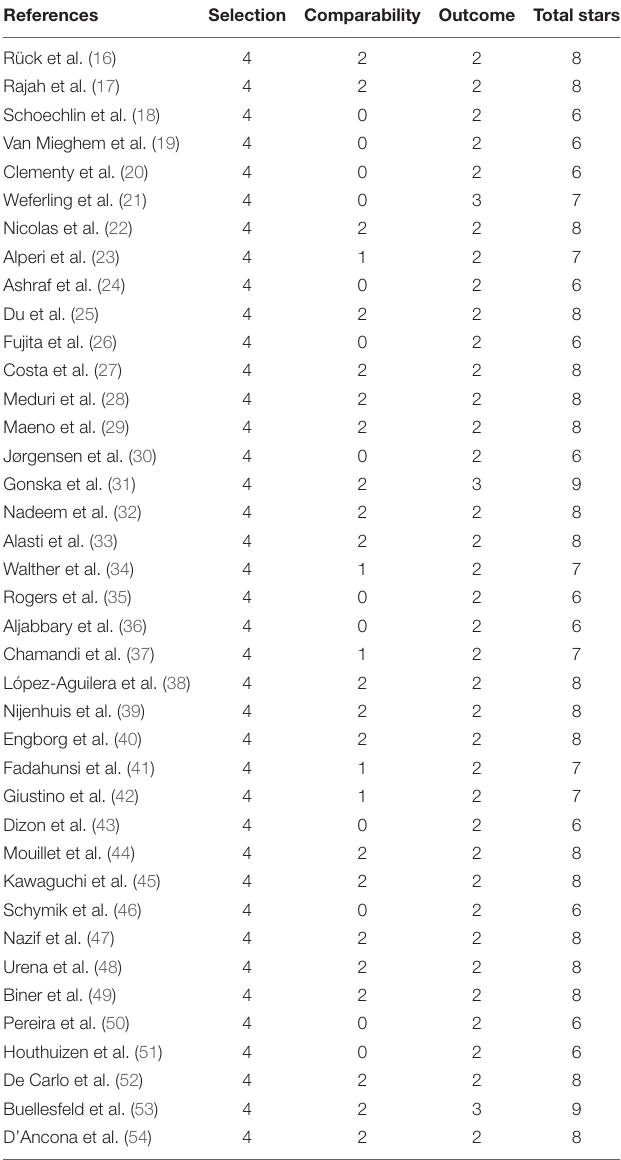
TABLE 2 | Quality assessment of the included studies according to the Newcastle-Ottawa Scale